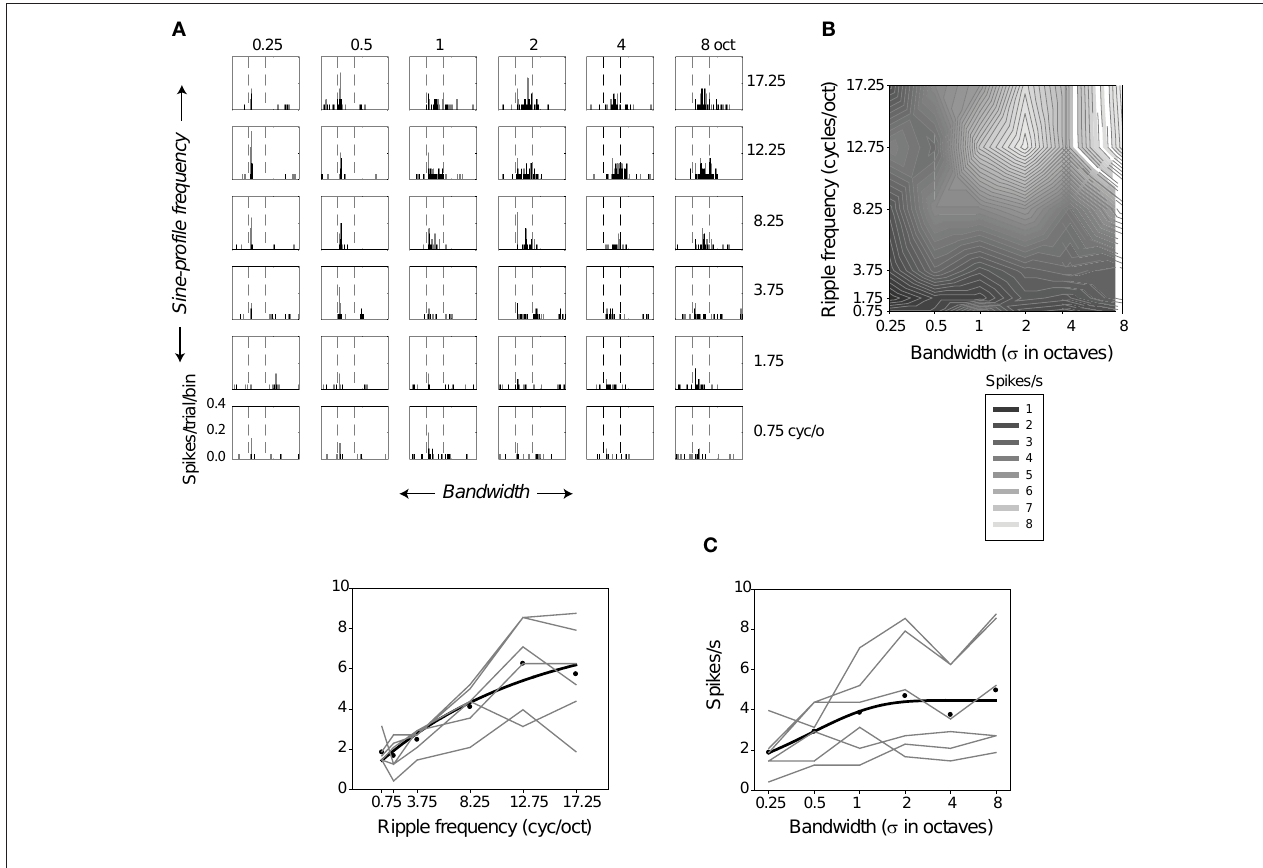
showing response strength at each level of ripple frequency ( — , left ), and at each level of bandwidth ( — , right ). The • indicate the mean rates averaged over bandwidth ( left ) or ripple frequency ( right ). The — represent the best fitting (negative) exponential growth functions ( y = y + a [1 − exp( − x / b )]) to the 0 mean